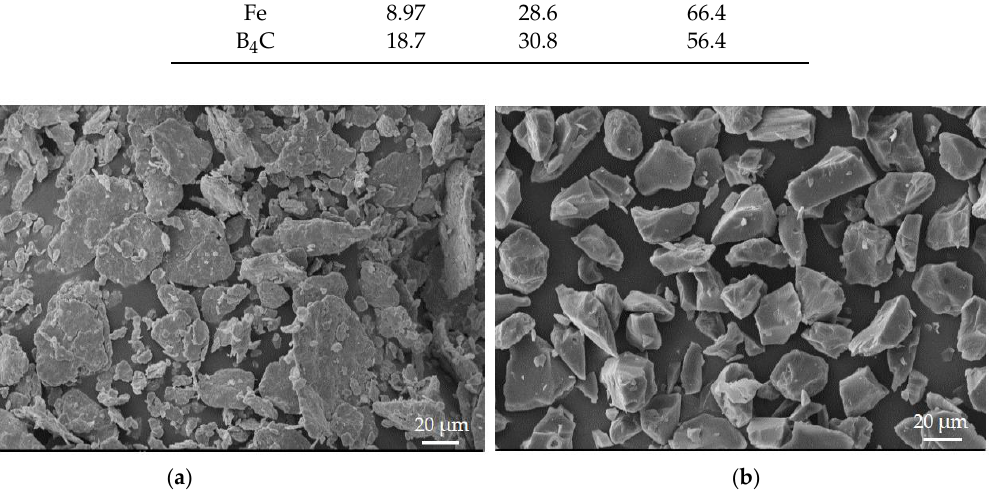
Figure 1. Scanning electron microscopy (SEM) images of the raw powders: ( a ) irregular and flake iron powders; ( b ) irregular polygonal and angular boron carbide particles.